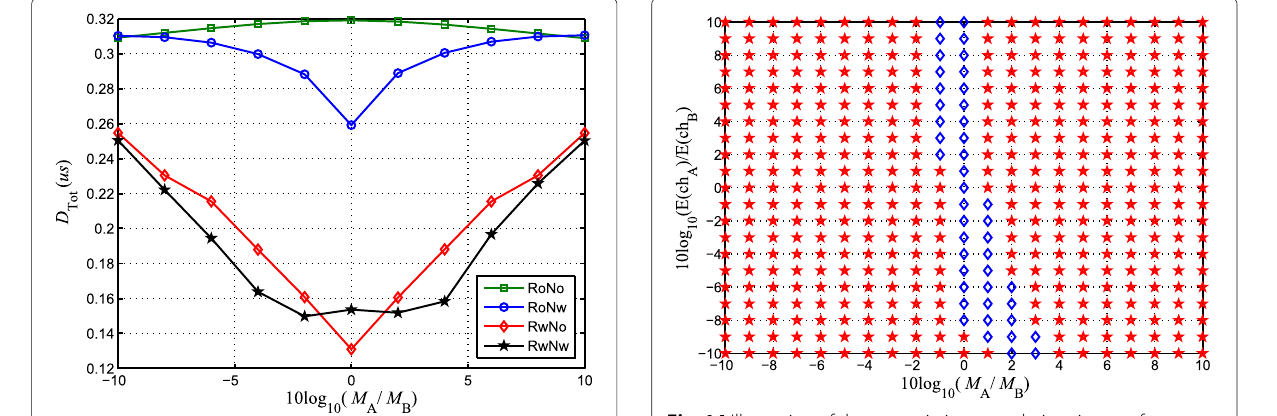
Fig. 14 Illustration of the transmission completion time performance regions of the four schemes. In the regions marked with red pentacle, blow lozenge, black circ, and green box, RwNw, RwNo, RoNw, and RoNo achieve the lowest delay among the four methods,